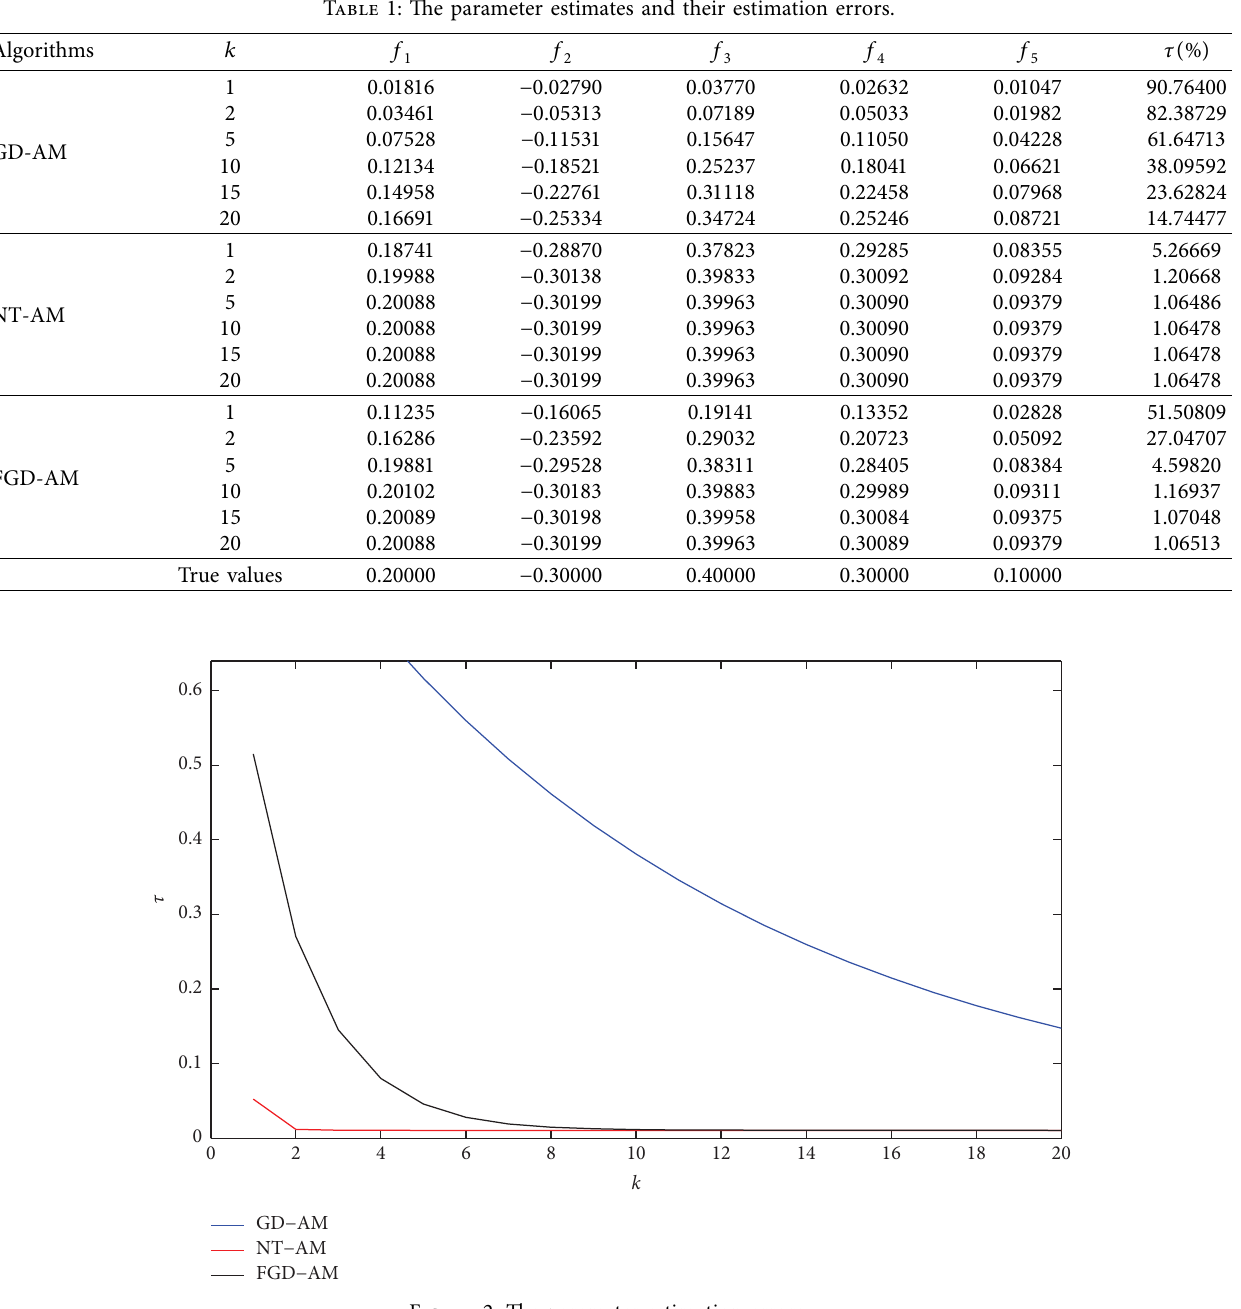
Figure 2: Te parameter estimation